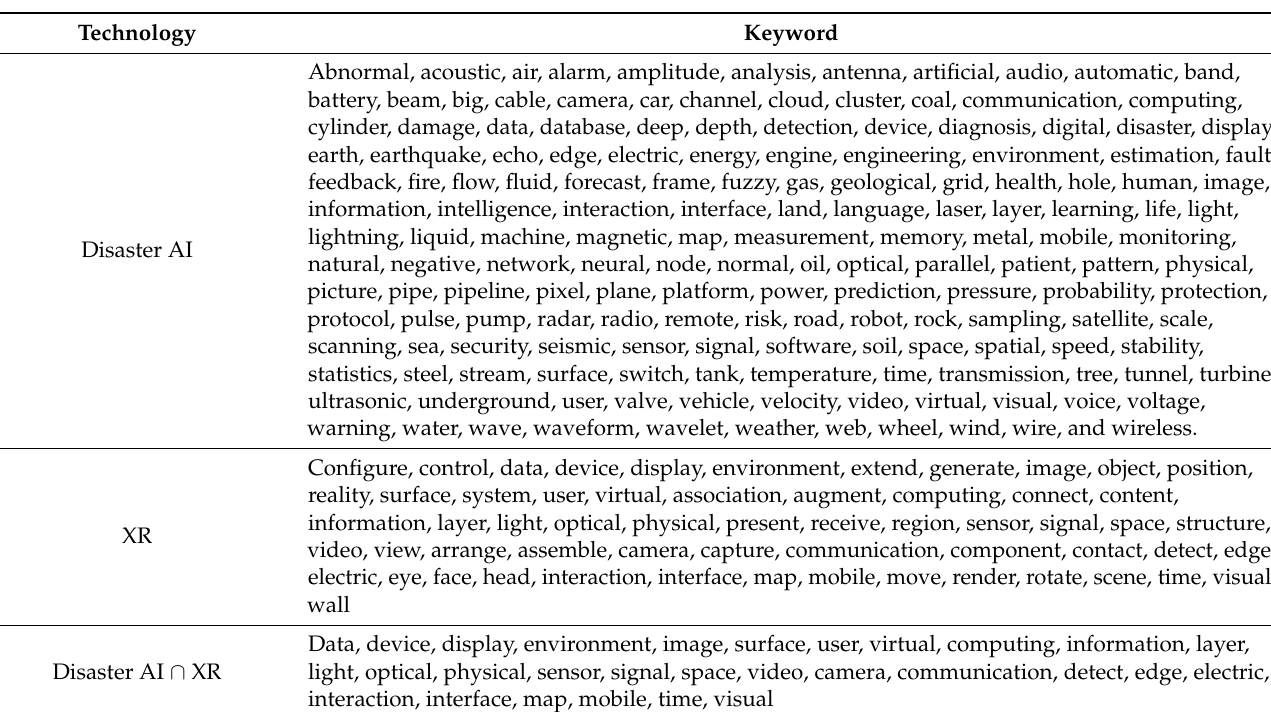
Table 1. Technology keywords of disaster AI, XR, and (disaster AI ∩